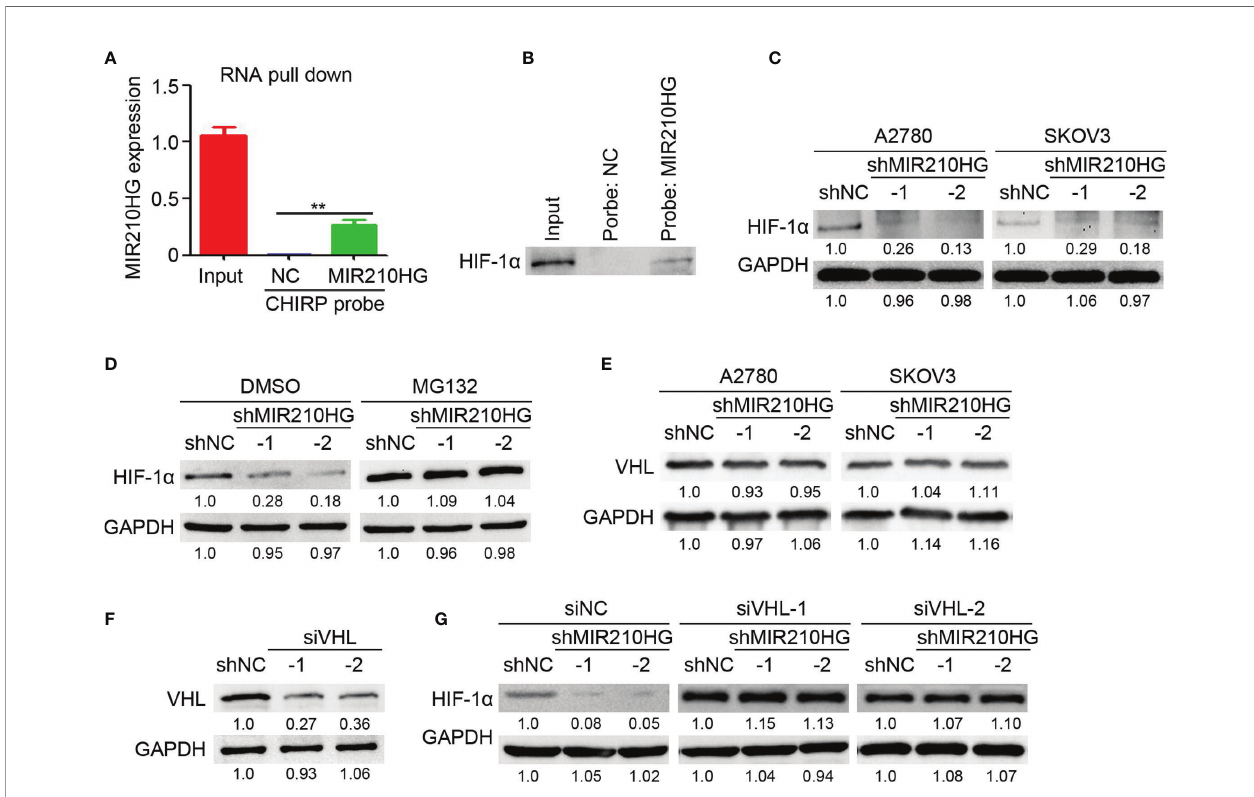
FIGURE 4 | lncRNA-MIR210HG inhibits HIF-1 a degradation in ovarian cancer. (A) A2780 cells that were cultured under hypoxia condition were collected for RNA pull down experiments with CHIRP probe targeting lncRNA-MIR210HG and negative control. qPCR analysis of lncRNA-MIR210HG expression in A2780 cells (Input) and products of RNA pull down (n = 3, **p < 0.01). (B) Detection of HIF-1 a expression in A2780 cells (Input) and products of RNA pull down. (C) Detection of HIF-1 a expression in A2780 and SKOV3 cells (under hypoxia condition) stably infected with lentivirus-shRNA targeting lncRNA-MIR210HG and negative control by western blotting. GAPDH was used as a loading control. (D) Detection of HIF-1 a expression in A2780-shNC and A2780-shMIR210HG cells (under hypoxia condition) treated with DMSO or MG132 by western blotting. GAPDH was used as a loading control. (E) Detection of VHL expression in A2780-shNC, A2780-shMIR210HG, SKOV3- shNC and SKOV3-shMIR210HG cells (under hypoxia condition) by western blotting. GAPDH was used as a loading control. (F) Detection of VHL expression in A2780 cells (under hypoxia condition) transfected with siRNA targeting VHL and negative control by western blotting. GAPDH was used as a loading control. (G) Detection of HIF-1 a expression in A2780-shNC and A2780-shMIR210HG cells (under hypoxia condition) transfected with siRNA targeting VHL and negative control. GAPDH was used as a loading